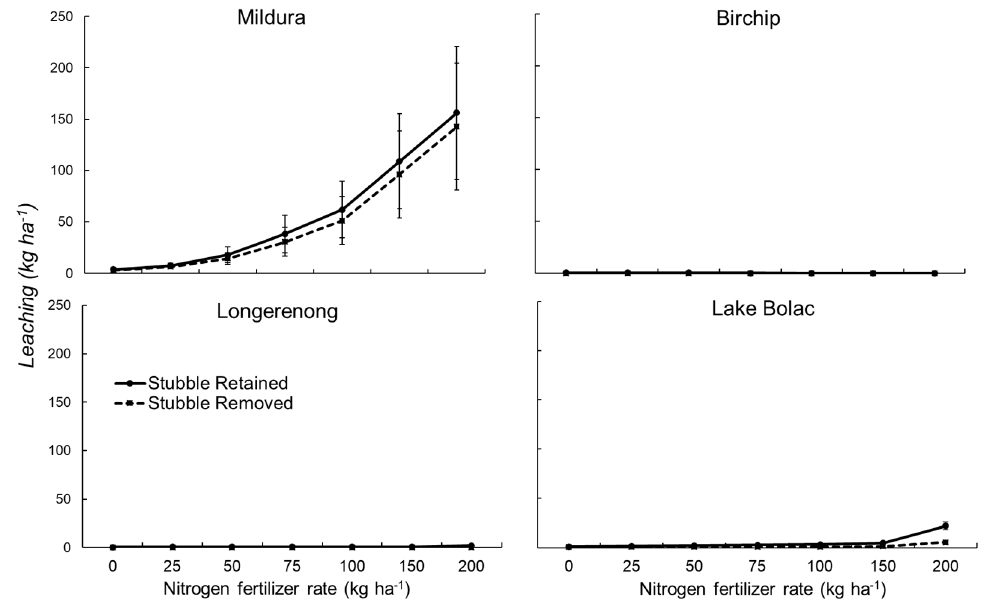
Figure 7. Effects of N application rate and stubble retention (retained vs. removed) on the mean (1990–2016) N leaching at four field sites. Error bars represent ± standard error of the mean over the years of the simulation.